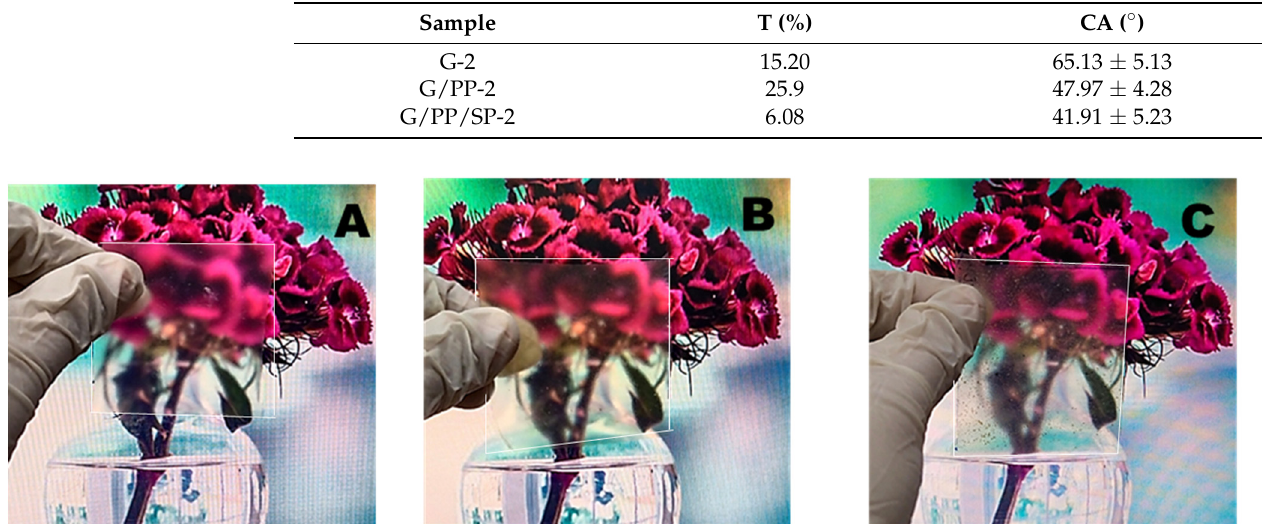
Figure 3. Transmittance spectra of edible films (black line indicates G/PP-2 film, blue line indicates G-2 film, and red line indicates G/PP/SP-2 film).